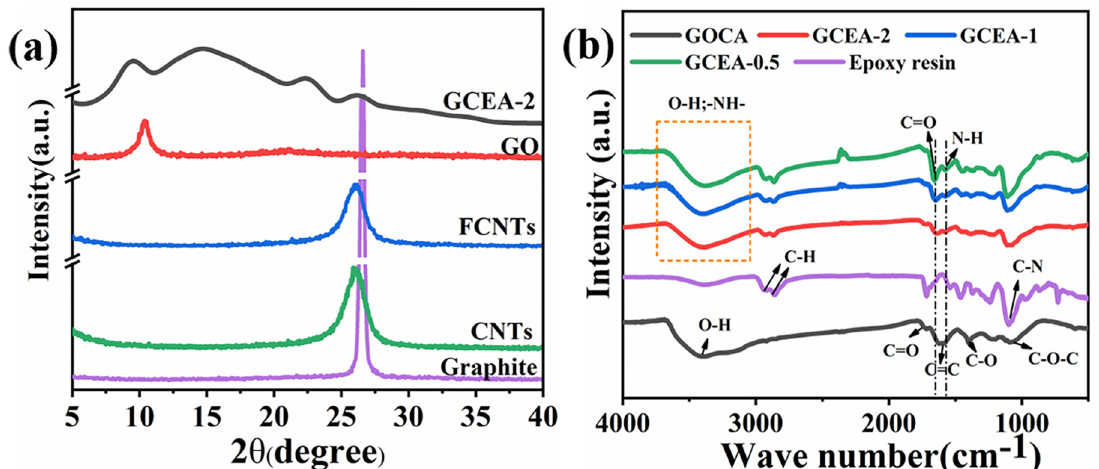
Figure 1. The XRD patterns ( a ) and FT-IR spectra ( b ) of the various samples (Color figure can be viewed online).